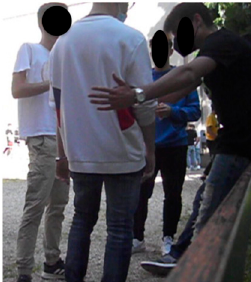
Figure 12. Original DSB image analysis using ViTFeatureExtractor. The class recognized by ViT is “bars”: the model pays attention to the foreground without considering the violent scene (push) in the center part of the image. The difficulty of image processing mainly depends on the nature of the videos or on the speed of the action in the scene, as in punches or hits, which in the reality are fast and uncontrolled. Although different extended techniques and mechanisms have been applied, the just-mentioned limitations highlight the problem of analyzing a real environment such as a school yard.